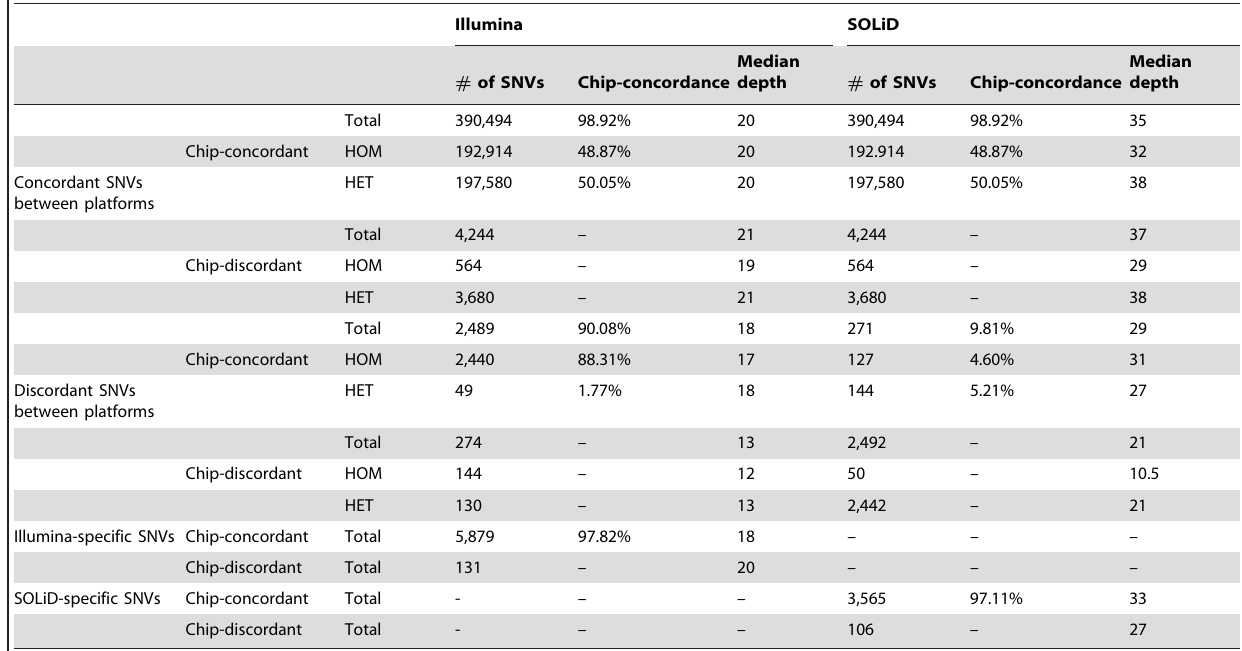
Table 1. Classification of sequenced SNVs and their chip-concordance.